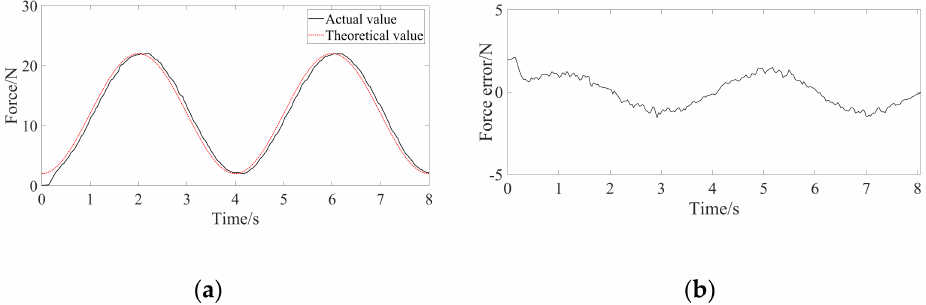
Figure 13. The sinusoidal force command following experimental results. ( a ) Sinusoidal command tracking curve. ( b ) Sinusoidal command tracking error curve.